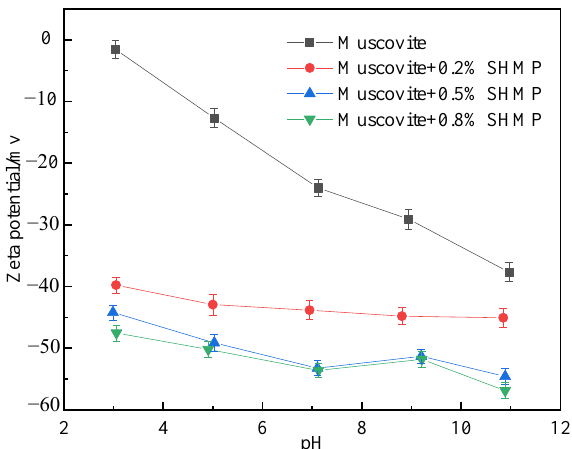
Figure 9. Influence of different dosages of SHMP on the surface potential of muscovite.